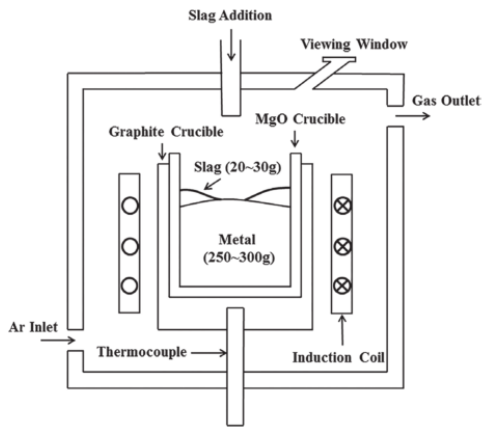
Figure 1. Diagram of the testing equipment.